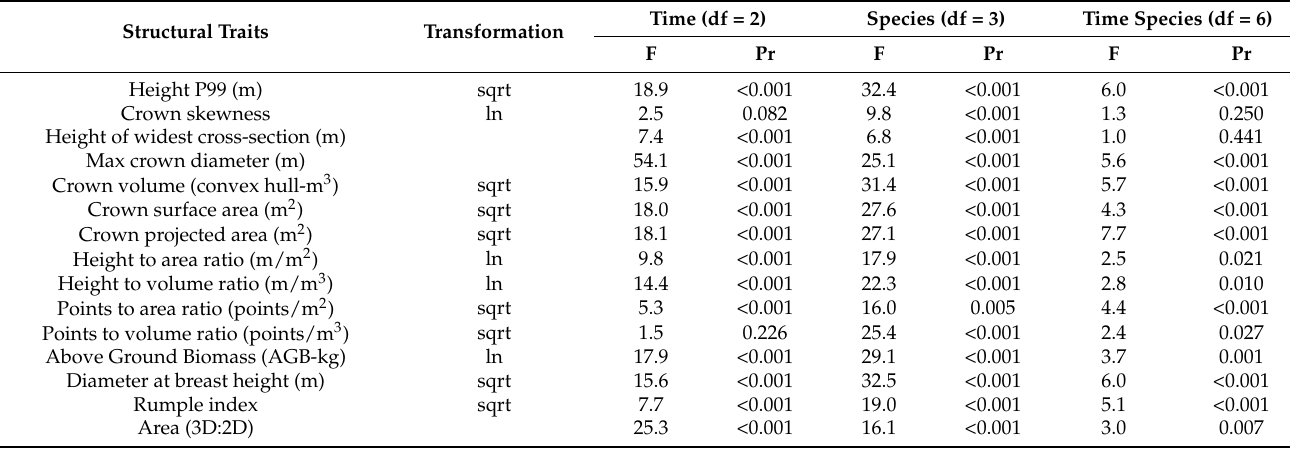
Table 3. Analysis of variance results for all trees within the study, showing the trait transformation and F-statistic and its probability (Pr) for Time, Species, and their interactions terms. The numerator degrees of freedom (df) for each factor fitted is shown in the heading in parenthesis, and denominator degrees of freedom ranged between 719 and 759 according to the structural trait analysed. 1 The trait descriptions are given in Table 2.